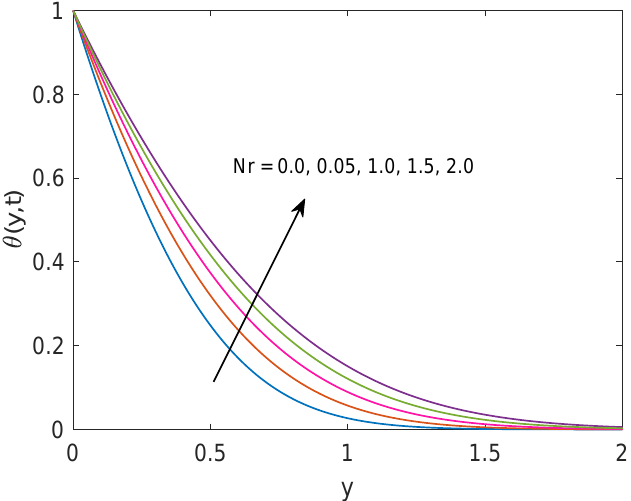
Figure 11. Temperature profile for different Nr when Q = 0.5, Pr = 6.2, φ = 0.1 and t =